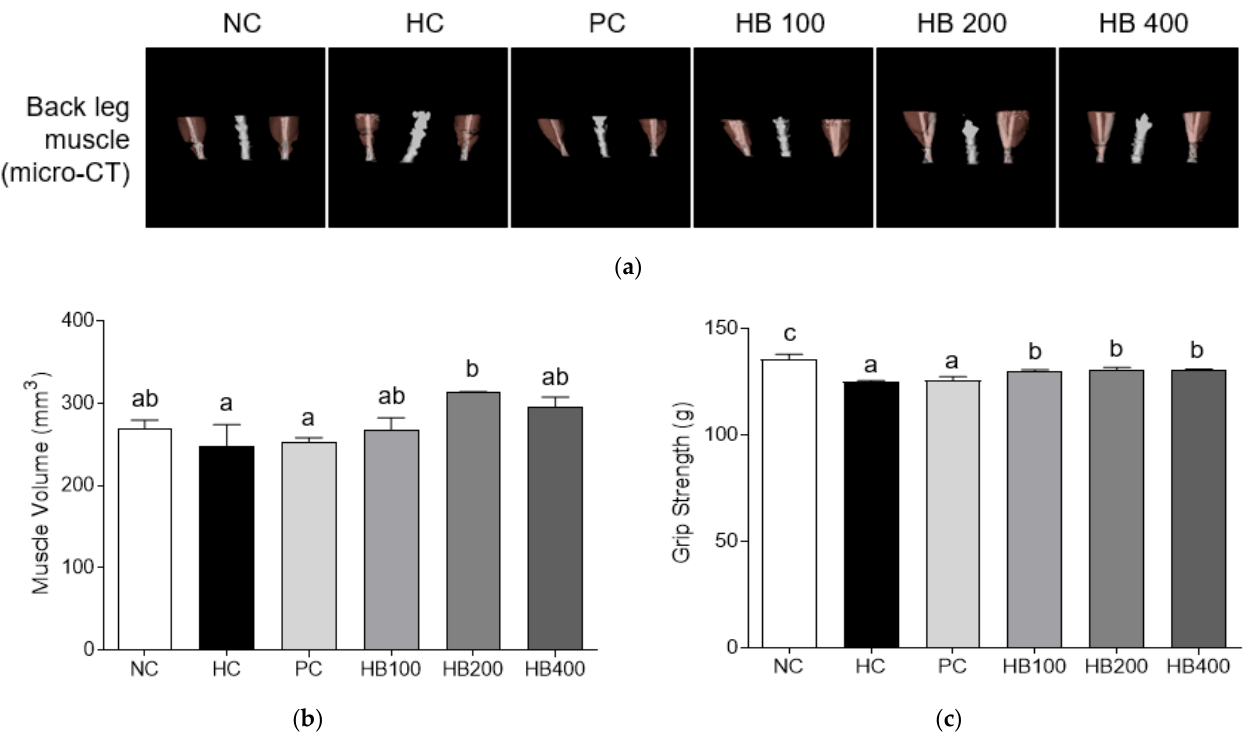
Figure 6. Effect of HB extract on muscle mass. ( a ) micro-CT analysis of hind limb muscle; ( b ) muscle volume; and ( c ) grip strength. NC, Normal diet Control; HC, HF diet control; PC, HF diet with orlistat at 20 mg/kg; HB100, HF diet with honeysuckle berry extract at 100 mg/kg; HB200, HF diet with honeysuckle berry extract at 200 mg/kg; HB400, HF diet with honeysuckle berry extract at 400 mg/kg. Data are presented as mean ± SD ( n = 8). Different letters indicate significant differences by one-way ANOVA ( p < 0.05) followed by Duncan’s multiple range